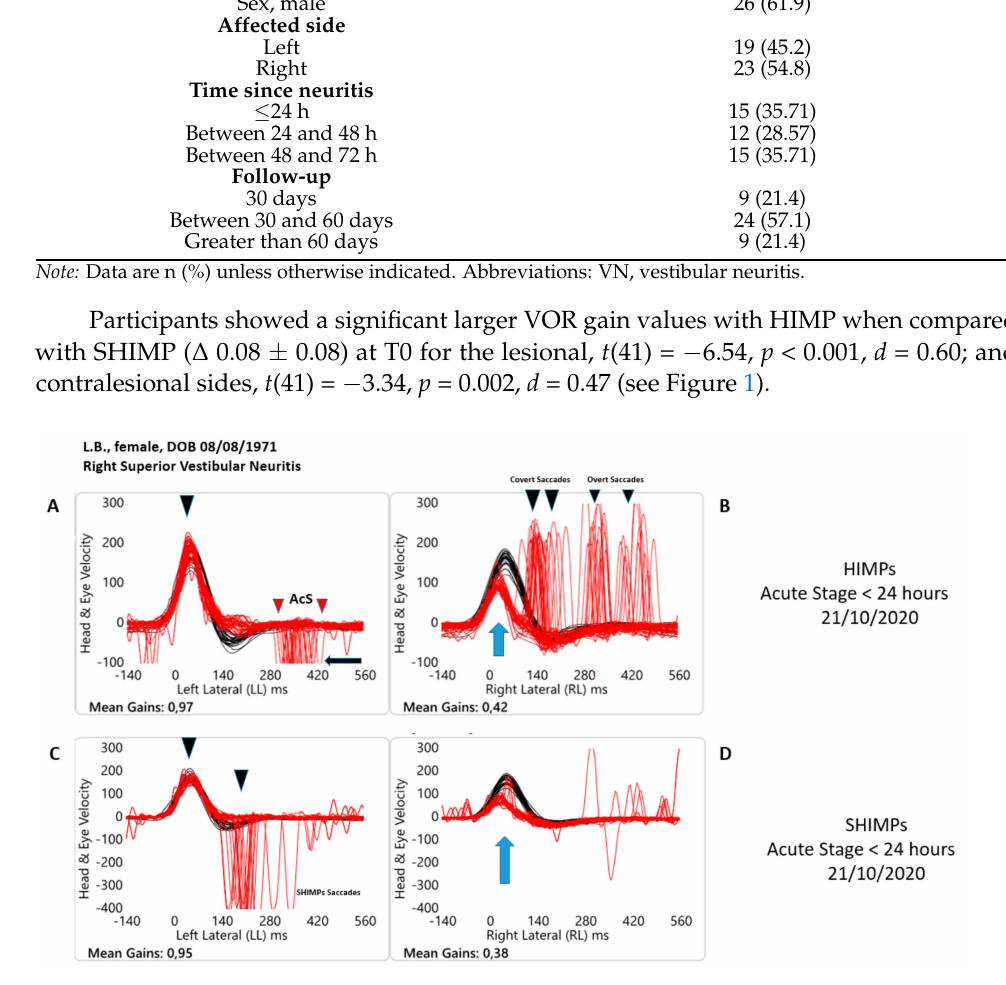
Figure 1. Objective measures of horizontal semicircular canal function at the time of the attack (<24 h) in both paradigm HIMPs ( A , B ) and SHIMPs ( C , D ) with video Head Impulse test Technology for one patient with acute unilateral (right) superior vestibular neuritis. Each panel shows a superimposed time series of head velocity (black for the head impulses) and the corresponding eye velocity (red) for the lateral canal dynamic function. The signs of head velocity for leftward impulses and of eye velocity for rightward impulses have been inverted to allow for easier comparison. Normal horizontal Vestibulo Ocular Reflex (VOR) gains are approximately 0.7–1.0 [4]. At the time of the attack ( A , B ) HIMP paradigm. For rotations to the affected side, eye velocity is substantially less than the corresponding head velocity during the head turn so the VOR is significantly less, VOR gain is 0.42, then for head turns to the healthy side, VOR gain is 0.97. There is a shower of compensatory (Covert + Overt) saccades during and at the end of the head turn (black arrow). When the head is turned to the left contralesional side, anti-compensatory saccades (AcS) eye movements in the direction of the head movement can be observed (red arrow). At the time of the attack ( C , D ) SHIMP paradigm. In this paradigm for rotations toward the affected side, eye velocity is substantially less than the corresponding head velocity (red traces vs. black traces). Note how during the head turn, the slow phase eye velocity of the VOR is significantly less also in comparison with the same value